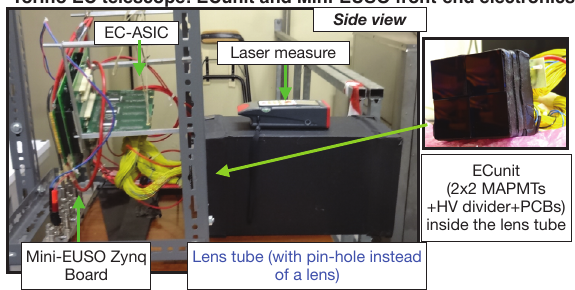
Figure 2: The Torino EC Telescope consists of an EC unit, EC-ASIC, Zynq Board, lens tube, 1” plano-convex lens, CPU (PC), external LV and HV power supplies. For the flasher measurements in the lab, a pin-hole of 0.1 mm in diameter, instead of the lens, is used to reduce light from the flasher